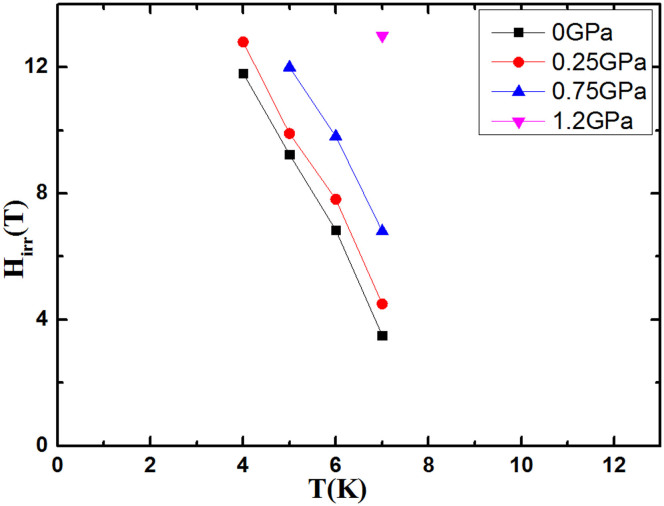
Hirr vs. T for different pressures.